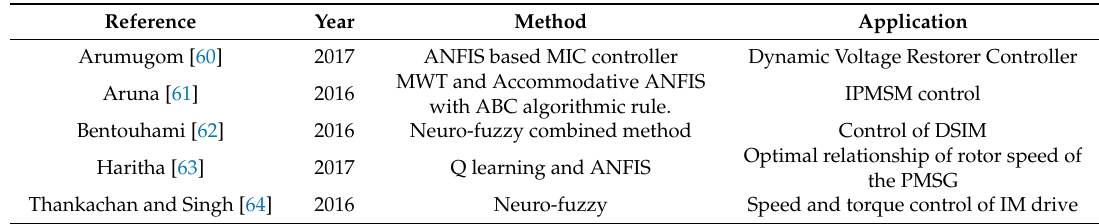
Table 2. Adaptive neuro-fuzzy systems in electrical machines.